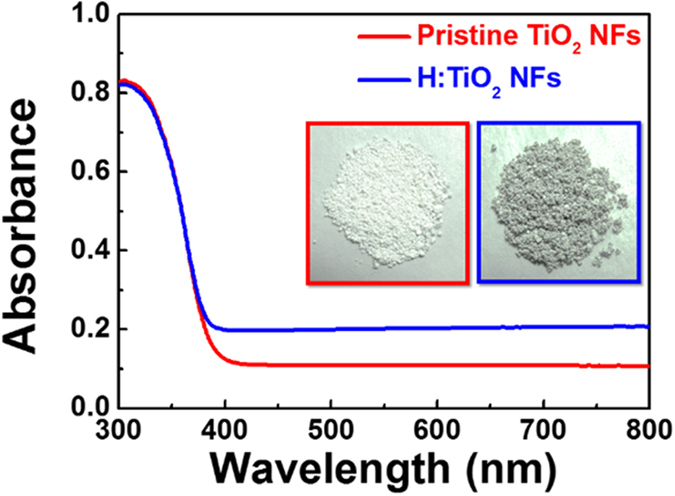
The absorbance spectra of pristine TiO2 NFs and H:TiO2; the insets are the corresponding powder photos.